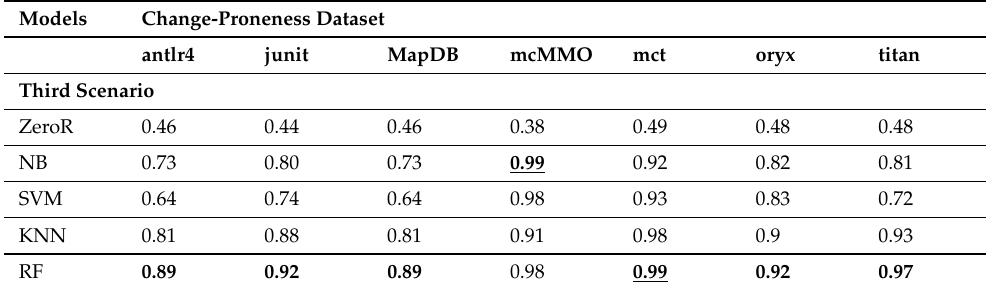
Table 14. AUC values for performance evaluation of prediction models across seven datasets in the third